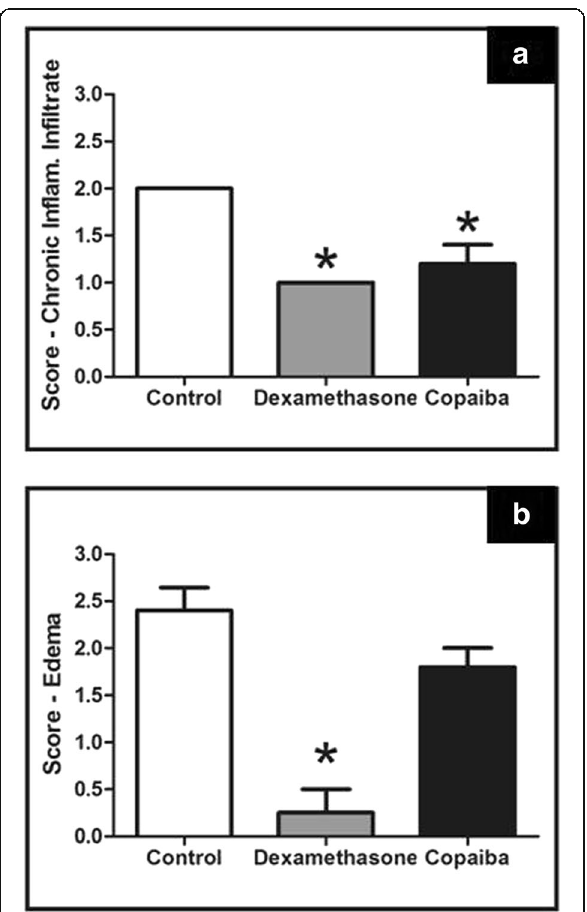
Fig. 3 Effect of treatment with copaiba oil-resin on transfixing lesions in rats ’ tongues comparing intensities of chronic inflammatory infiltrate and edema. The results are expressed as mean ± SE of the scores attributed to each variable analyzed. Panel ( a ): variable chronic inflammatory infiltrate; Panel ( b ): variable edema ( n = 5 animals per group). * p ≤ .05 compared to control group (Kruskal-Wallis test, followed by Dunn